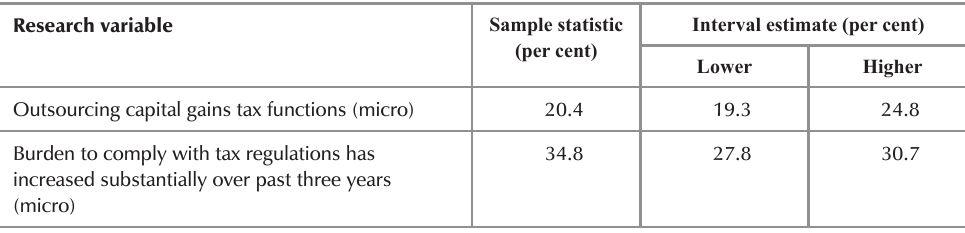
Interval estimates for selected research variables Research